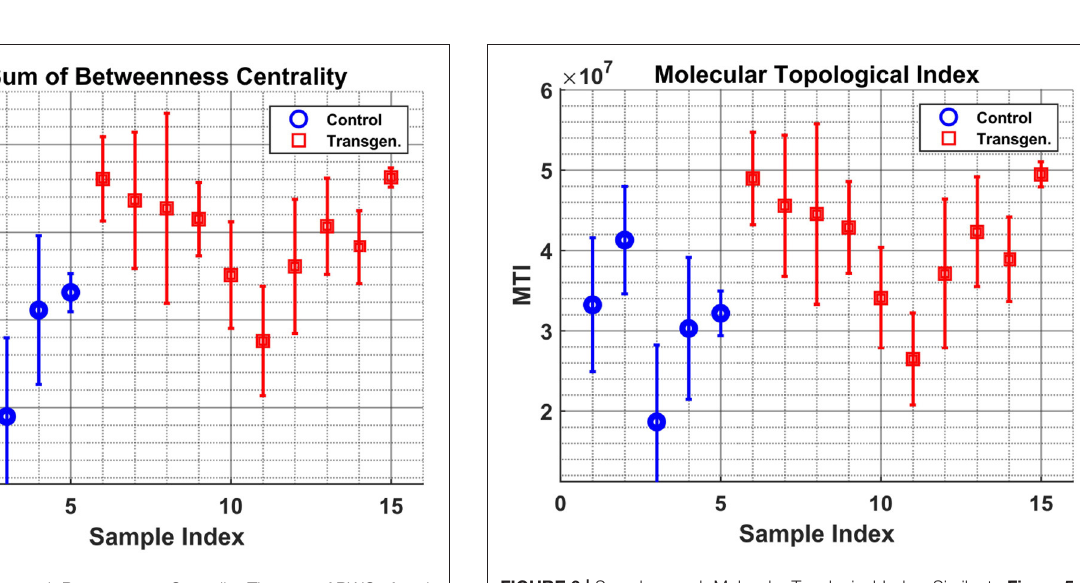
FIGURE 5 | Samples graph Betweenness-Centrality. The sum of BWC of each sample (indices [1–5] - Control, [6–15] - Transgenic) is shown along with the 1 σ errorbar.